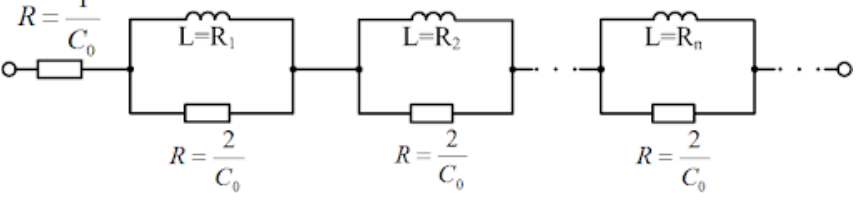
Figure 2. The synthesis of the equivalent magnetic reluctivity ˆ ν = 1